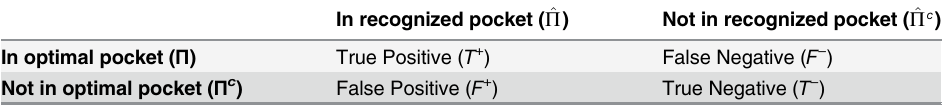
Table 1. Confusion matrix for pocket evaluation.